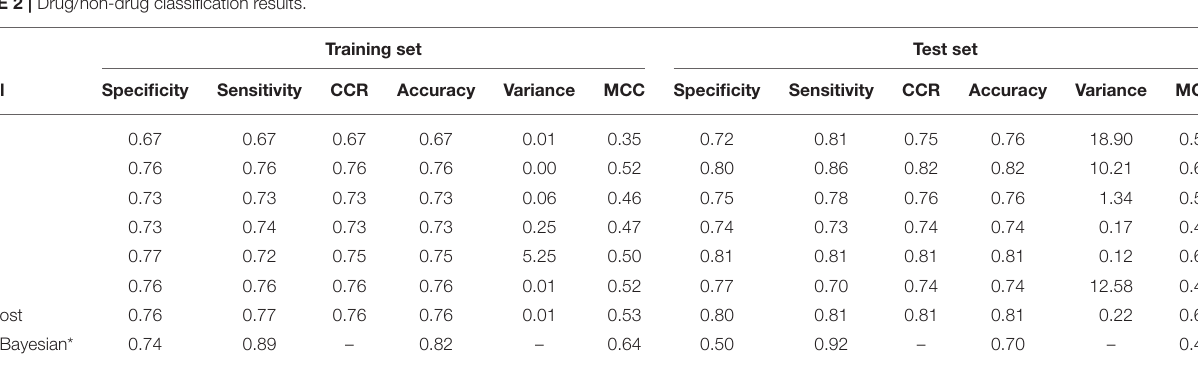
FIGURE 1 | (A) 3D representation of the Drug/Non-drug feature space using the t-SNE algorithm for dimension reduction. (B) A zoom into the drug area from the black square in (A) . TABLE 2 | Drug/non-drug classification